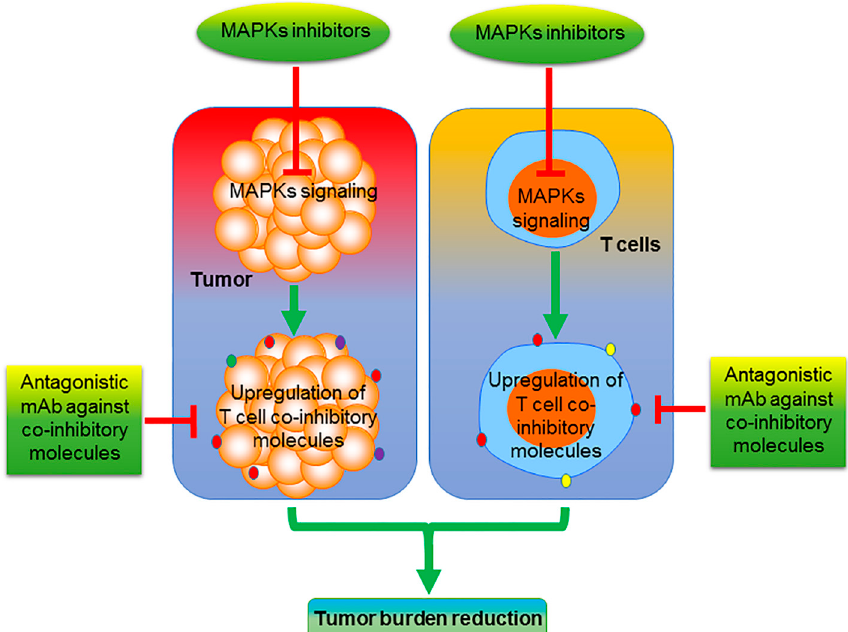
Figure 2. Schema describing the potential induction of T-cell coinhibitory molecules as an unintended consequence of MAPK inhibition. In the proposed model, we suggest that MAPK inhibition may lead to the unintended upregulation of coinhibitory, immune checkpoint molecules on the surface of cancer and T cells alike, which may facilitate tumor escape from immune surveillance. mAb, monoclonal antibody.